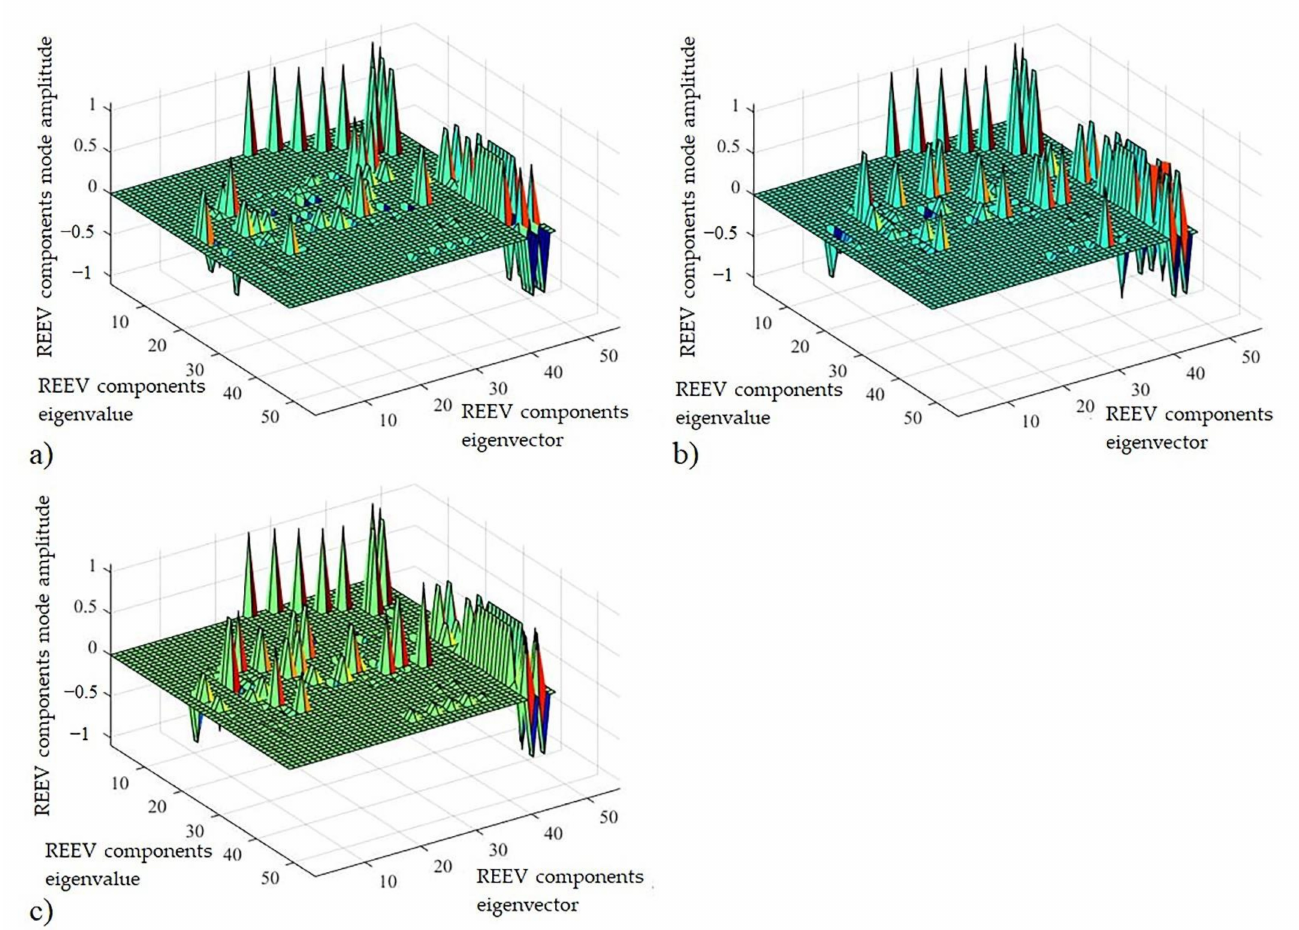
Figure 11. Mode shape analysis of linearised REEV model on; ( a ) tarmac; ( b ) polished ice; ( c )